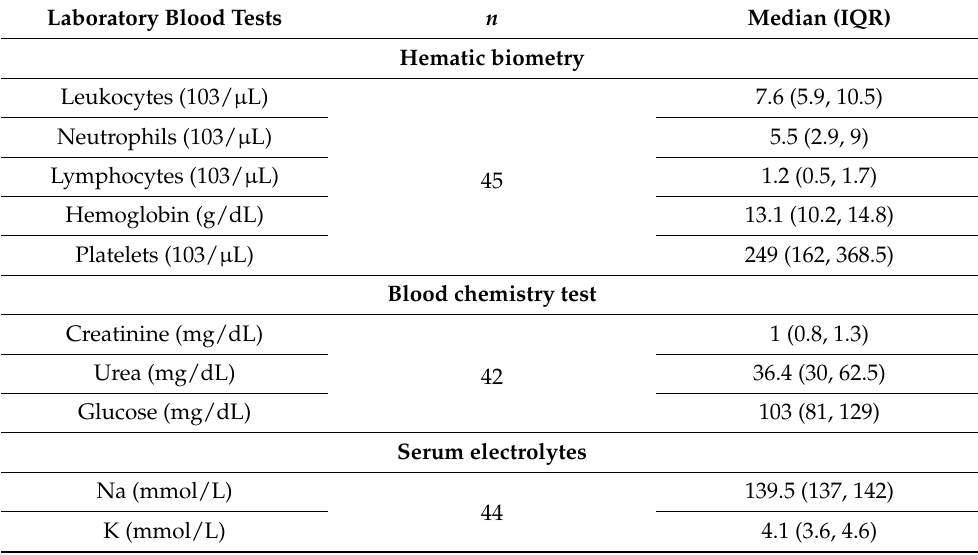
Table 6. Laboratory blood